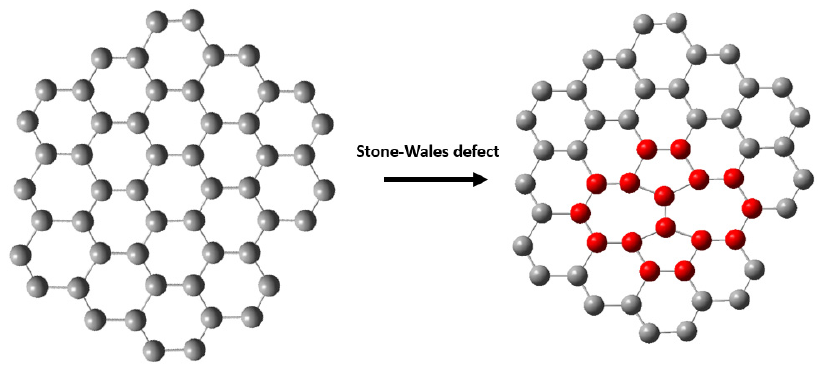
Figure 18. Stone–Wales defect.